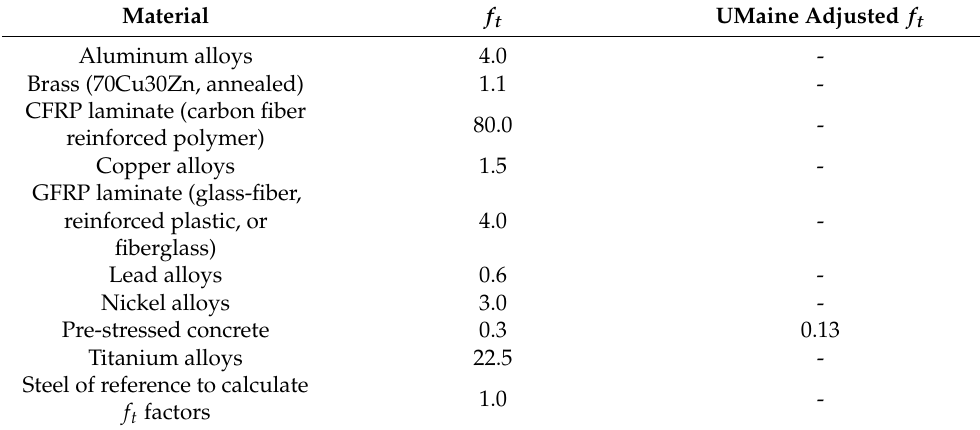
Table 11. Metric space material factors.